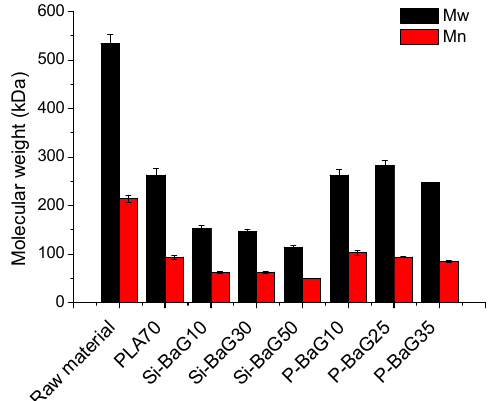
Figure 1. The number-average (M n ) and weight-average (M w ) molecular weights of the raw material and the as-processed PLA70 and composites.